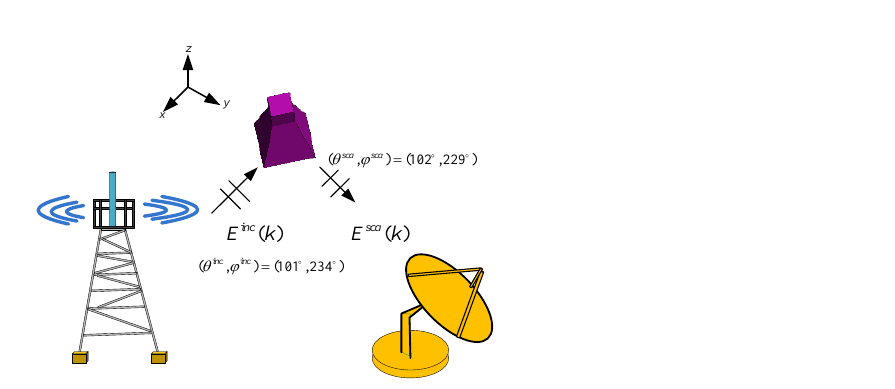
Figure 8. RCS frequency response of the coated composition of the MoM (EFIE-PMCHWT), AWE, and EFIE-PMCHWT-CAT. 4.2. A Coated Boat Nowadays, fast prediction of the bistatic RCS of a complex target based on ocean scenarios is essential. In the second example, we consider a simplified boat (PEC) covered by the dielectric, and the posture and size of the model is illustrated in Figures 9 and 10.